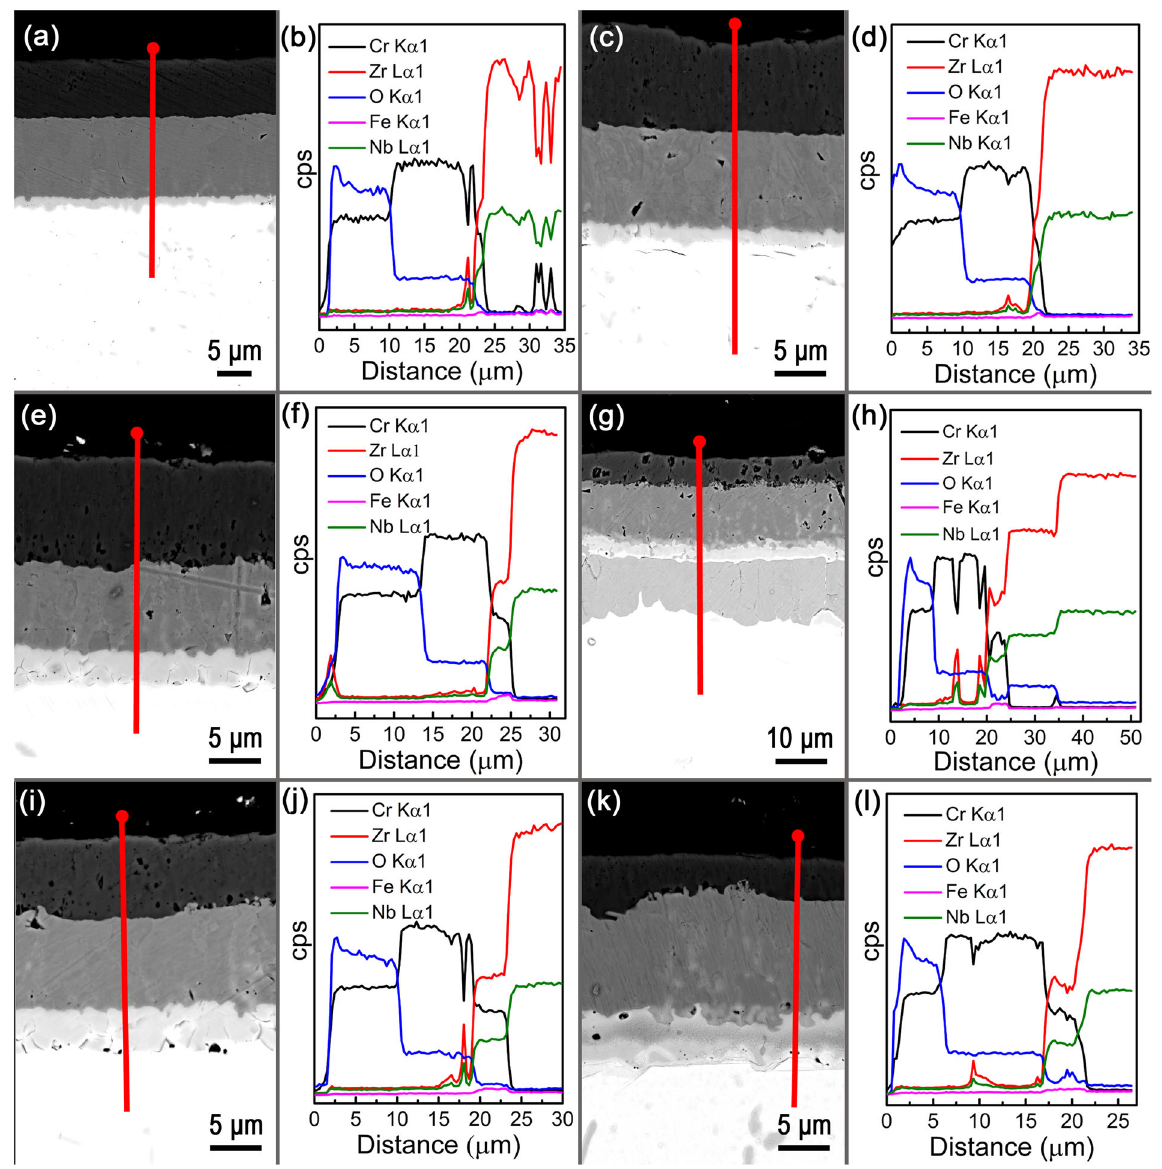
Fig. 5 Cross-sectional SEM images and corresponding EDS line scan of the outer surface of Cr-coated Zr tube oxidized at different conditions. a , b 1200 o C/0.5 h, c, d 1200 o C/1 h, e, f 1200 o C/2 h, g, h 1200 o C/4 h, i, j 1300 o C/0.5 h, k, l 1300 o C/1